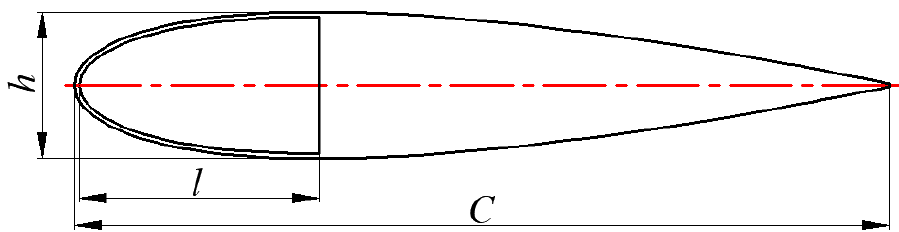
Figure 2. Sketch map of the blade for the simulation.